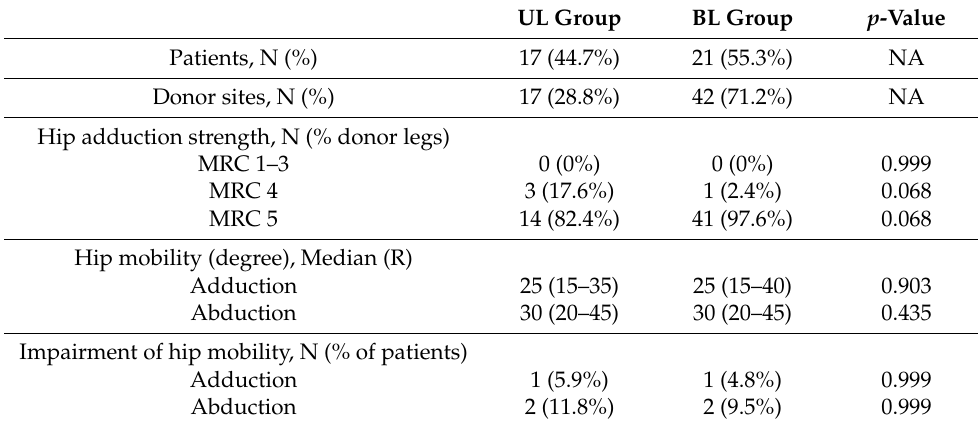
Table 2. Lower extremity function.